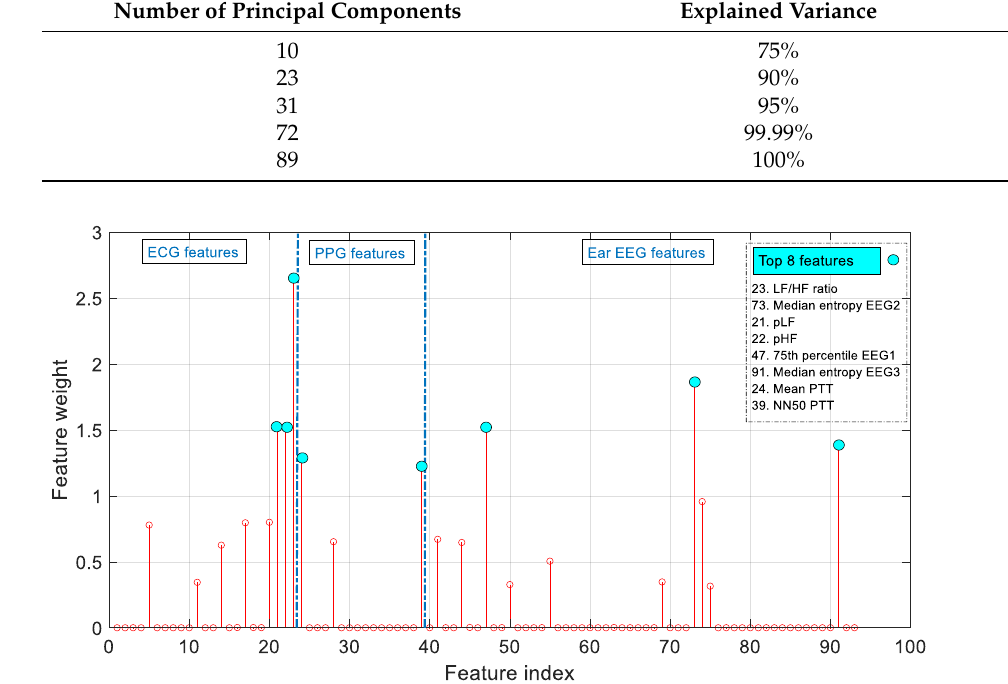
Table 3. Variance of original data captured by different number of principal components.